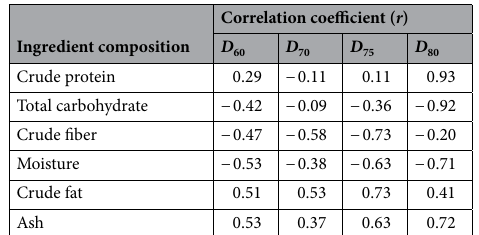
Table 5. Pearson correlation’s coefficients ( r ) of feed ingredient compositions and D T of ASFV in feed ingredients.